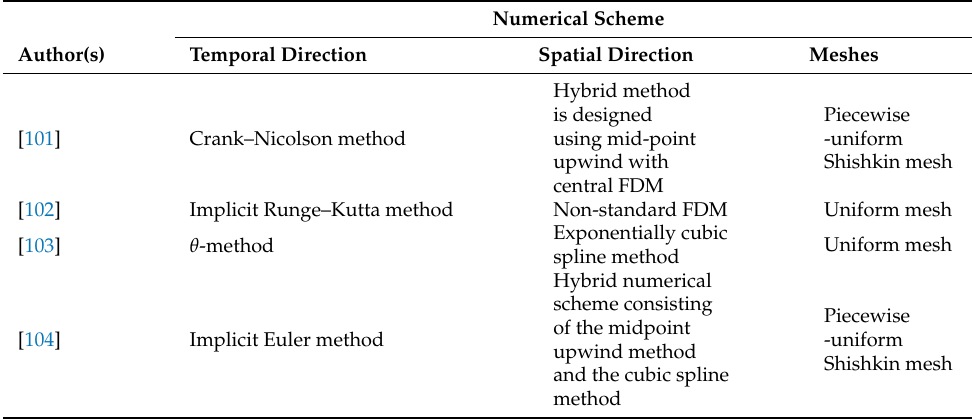
Table 13. Various methods and mesh used to solve Equations (19) and